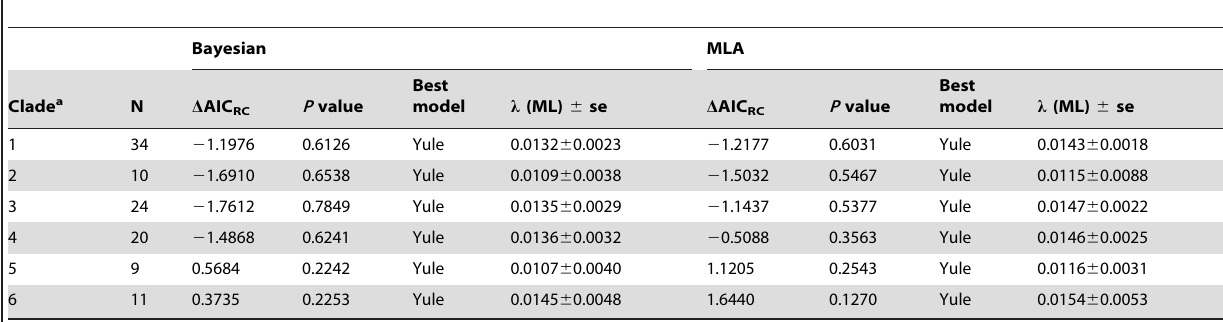
Table 3. Diversification rates and model of speciation for the major clades of Aeromonas.